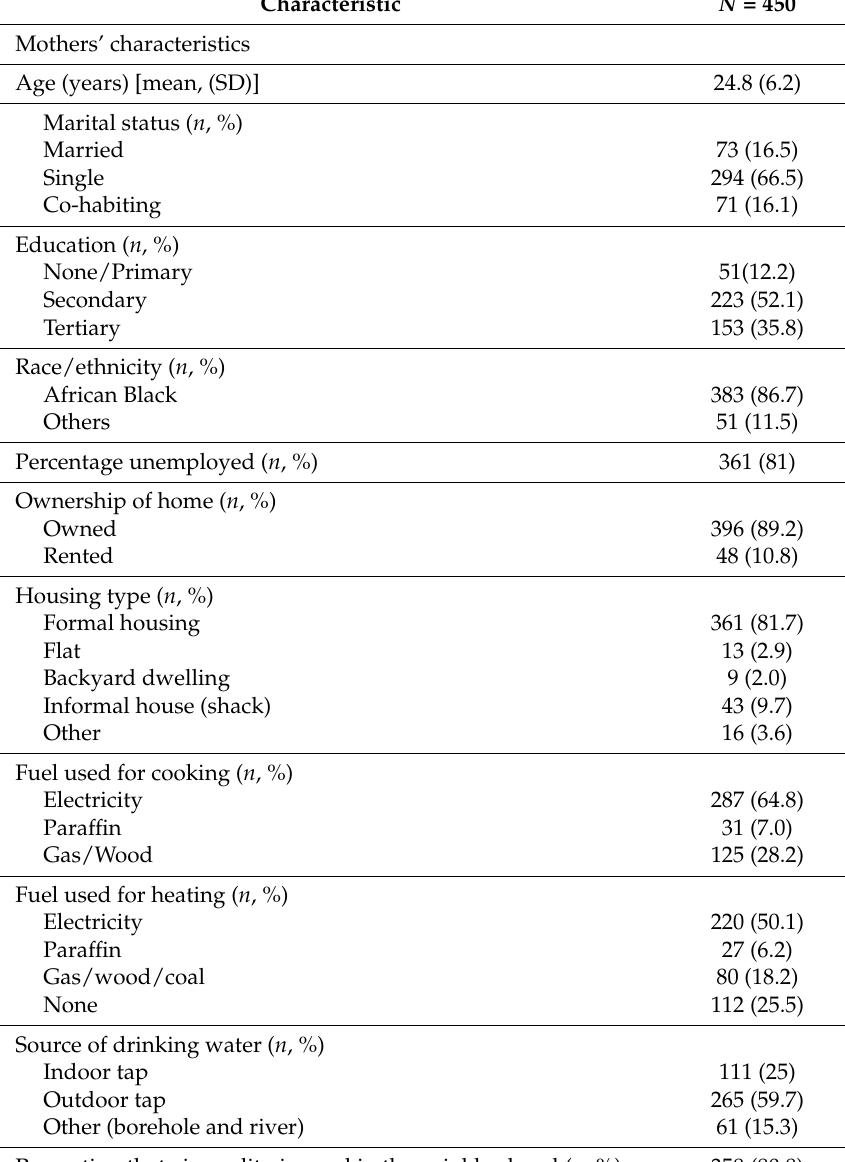
Table 1. Socio-economic characteristics of study